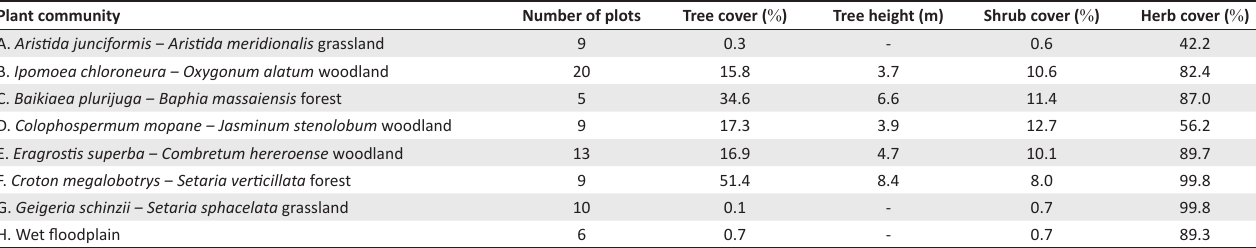
TABLE 1: Mean tree cover, tree height, shrub cover and herb cover for the eight plant communities. Plant community Number of